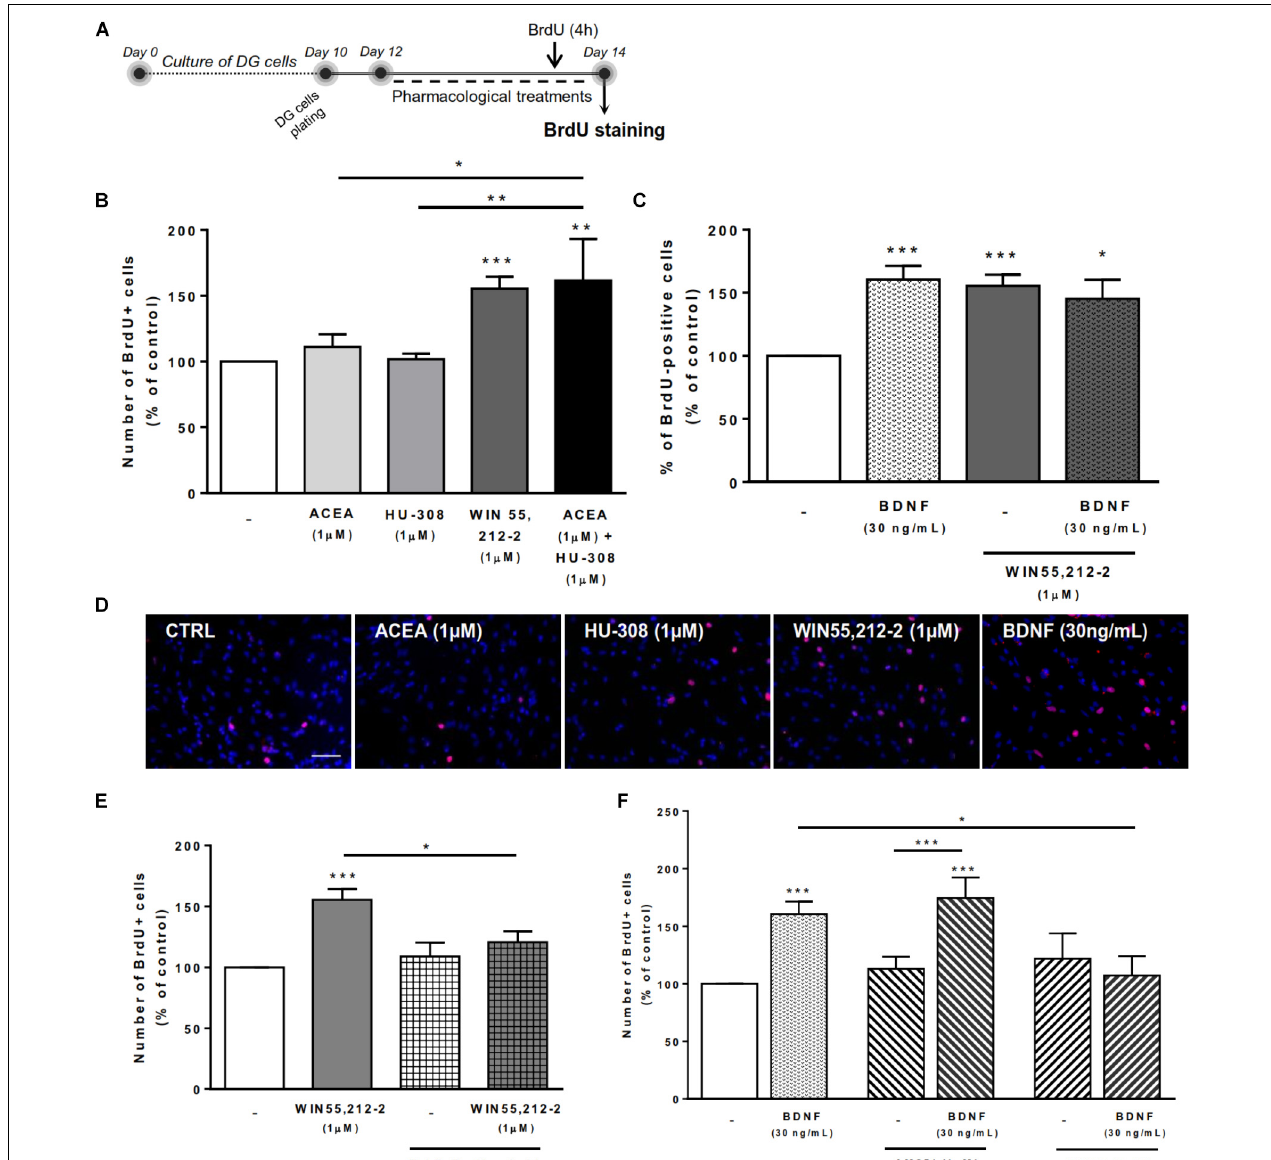
FIGURE 5 | BDNF-CB2R interaction modulates DG cell proliferation. CB1R activation together with CB2R activation promoted DG cell proliferation, an effect dependent on the presence of BDNF. CB2R, but not CB1R, blockage abrogated BDNF-mediated increase in DG cell proliferation. (A) Schematic representation of the experimental protocol. Day 0 represents the day of cultures; at Day 10 DG neurospheres were plated for 48 h and at Day 12 cells were exposed to pharmacological treatments for further 48 h (Day 14). (B,C,E,F) Bar graphs depict the percentage of BrdU-positive cells. Values were normalized to the control mean for each experiment and are represented as mean ± SEM. Control was set to 100%. n = 6–17. ∗ p < 0.05 and ∗∗∗ p < 0.001 using Dunnett’s multiple comparison test. (D) Representative fluorescent digital images of cells immunopositive for BrdU (in red) and Hoechst 33342 staining (blue nuclei). Scale bar = 50 µ